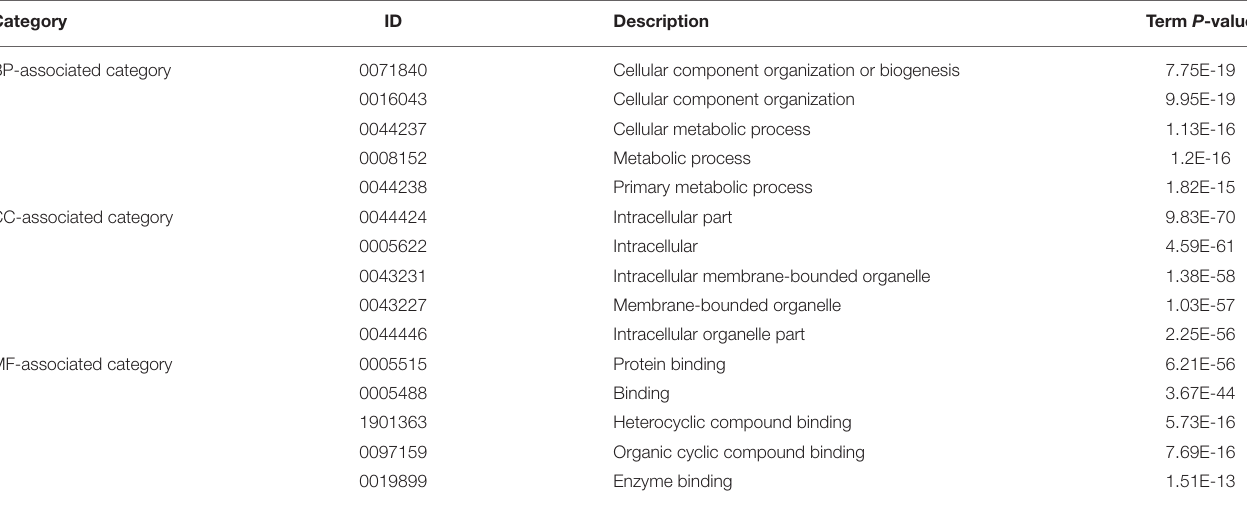
TABLE 3 | The most significantly enriched GO